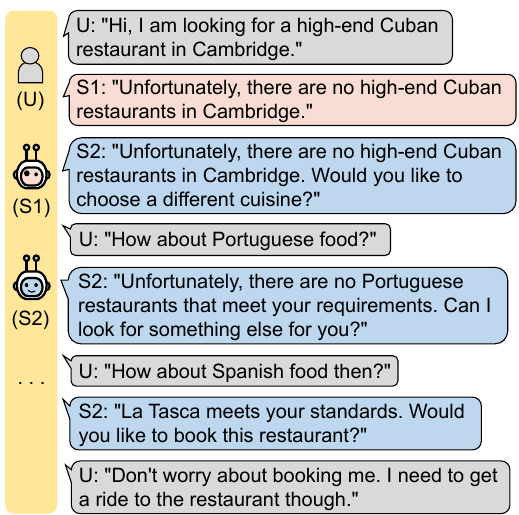
Figure 1. The system (S2) that uses well-specified rewards can guide the user through the goal, while S1